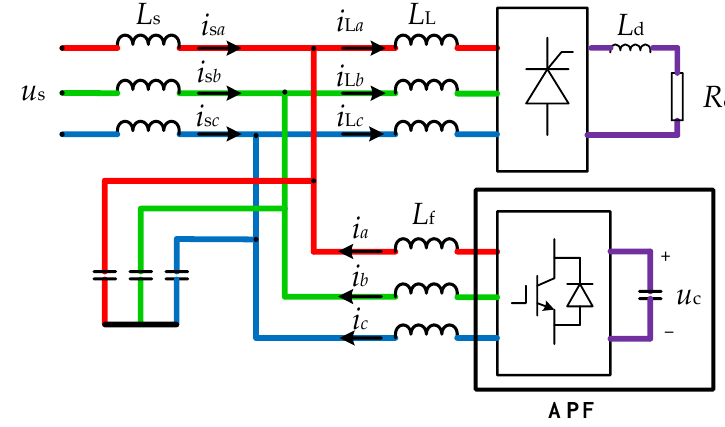
Figure 12. Simulation model with APF.